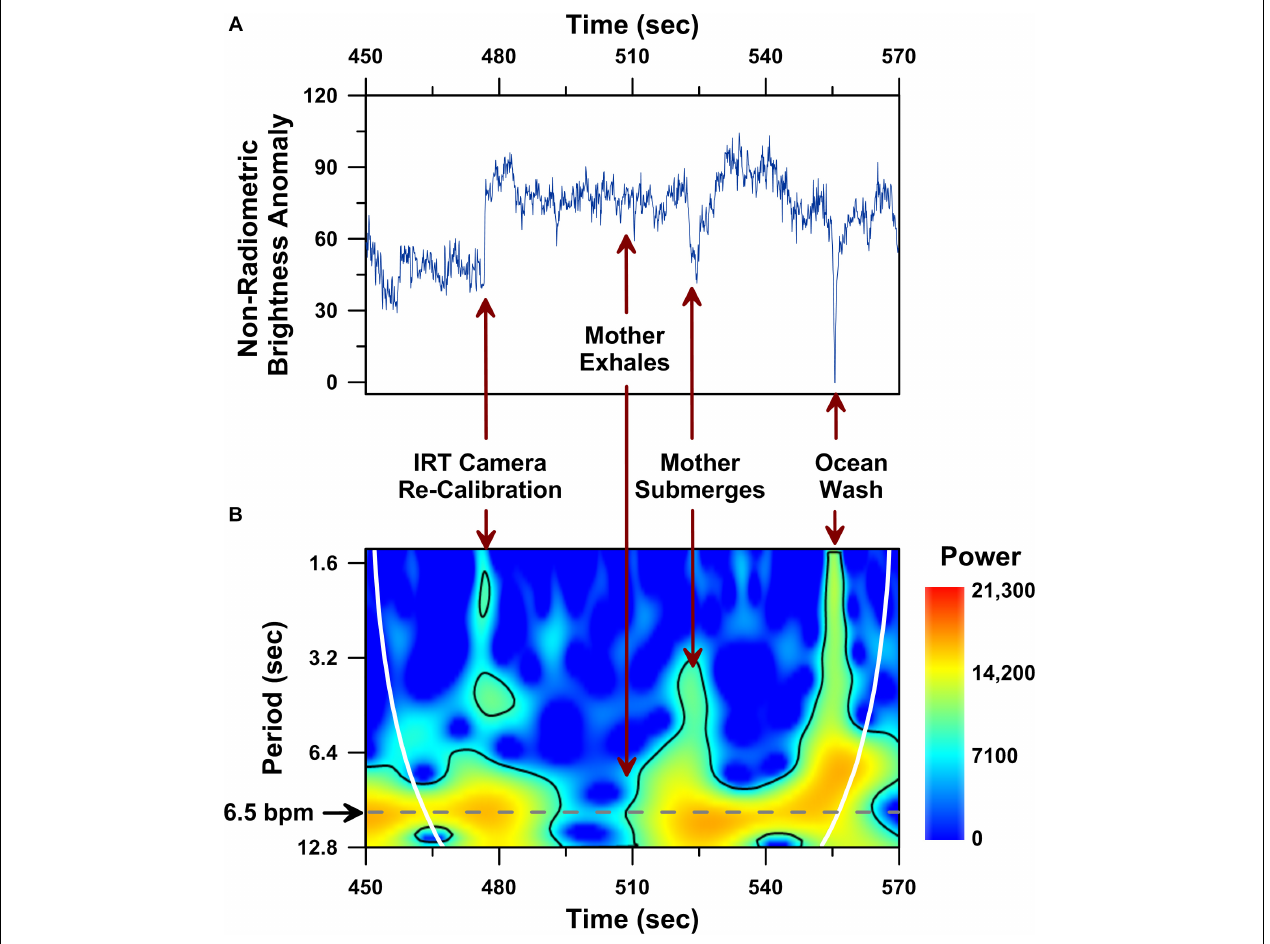
FIGURE 5 | Dorsal fin non-radiometric brightness temperature time series analysis performed on a 120 s-long UAS-IRT recording of the same mother humpback whale reported in Figure 4 . Time series plot of raw non-radiometric dorsal fin hot-spot brightness temperatures (A) , including: (i) brightness temperature effects of an IRT camera re-calibration (i.e., flat field correction) at 477 s; (ii) whale submergence at 523 s; (iii) ocean water washing over the whale’s dorsal fin at 555 s. Wavelet power spectrum showing significant ( p < 0.05) periodicities (i.e., higher power areas inside the solid black line) present in the same 120 s-long record (B) . Cone of influence indicated by white line in B